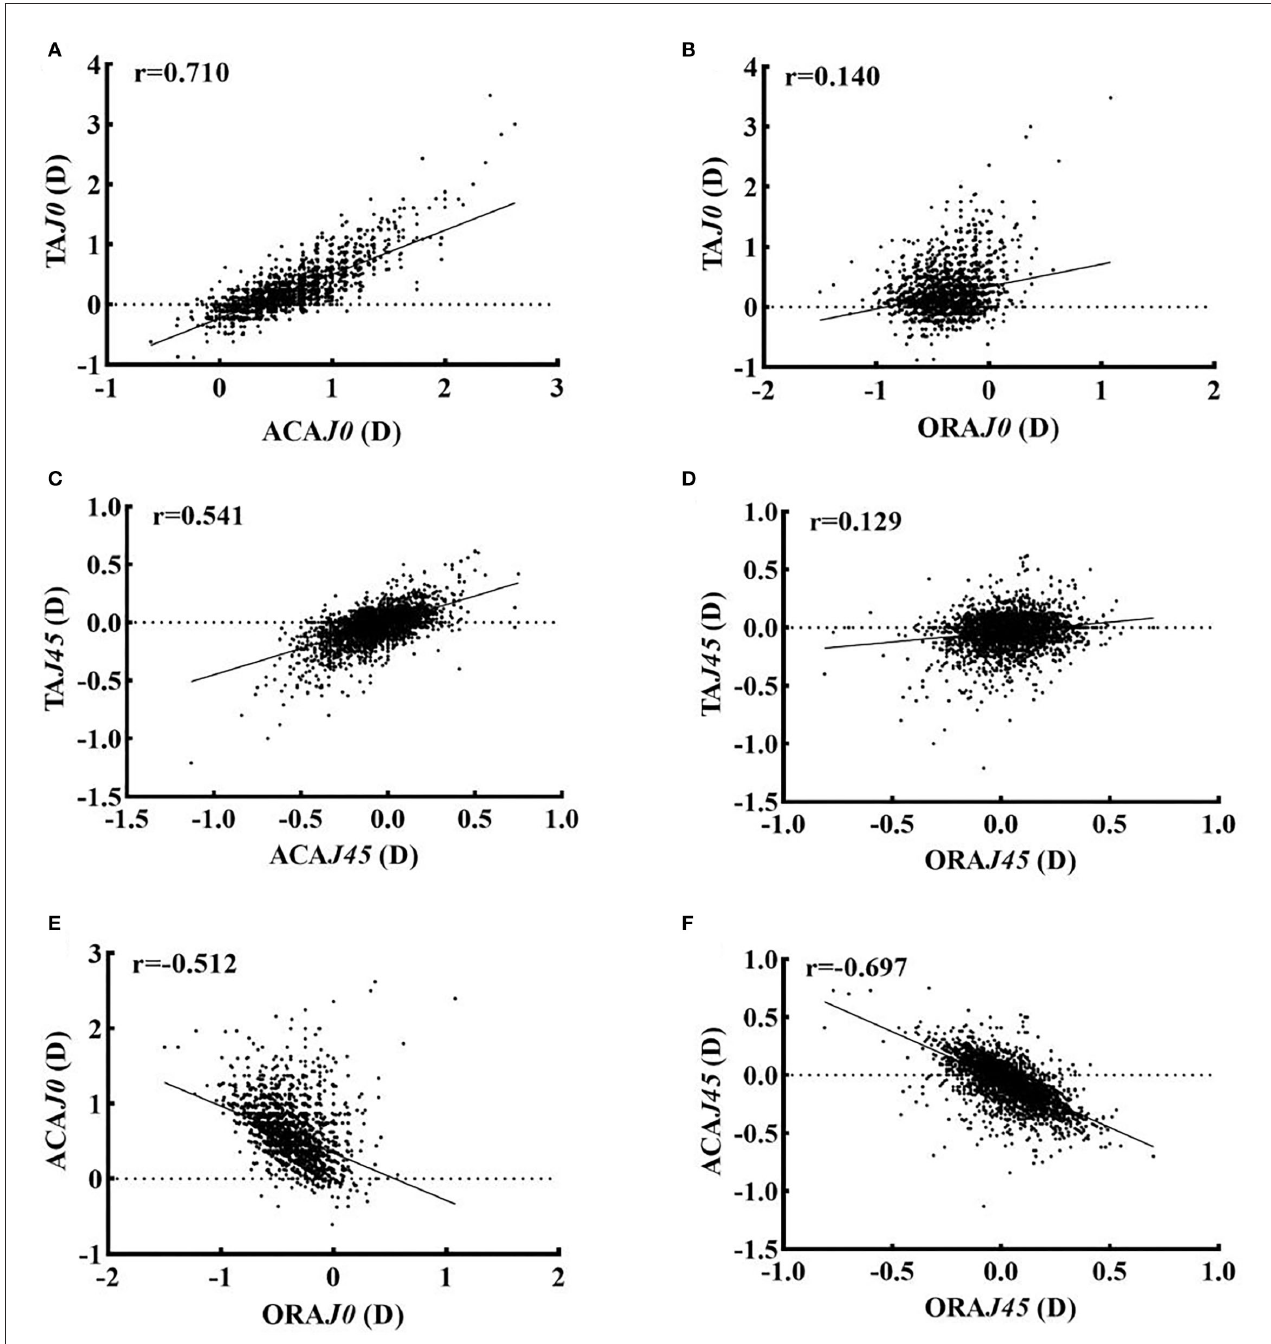
FIGURE1 Spearman correlation analysis were used to analyze the correlation of TA, ACA, and ORA in J0 , and J45 components. (A) ACA J0 vs. TA J0 . (B) ORA J0 vs. TA J0 . (C) ACA J45 vs. TA J45 . (D) ORA J45 vs. TA J45 . (E) ACA J0 vs. ORA J0 . (F) . ACA J45 vs. ORA J45 . J0 and J45 components represent the orthogonal (power of Jackson cross cylinder at 90 ◦ and 180 ◦ ) and oblique (power of the Jackson cross cylinder at 45 ◦ and 135 ◦ ), respectively. TA, Total Astigmatism; ACA, Anterior Corneal Astigmatism; ORA, Ocular residual astigmatism; D, diopter.